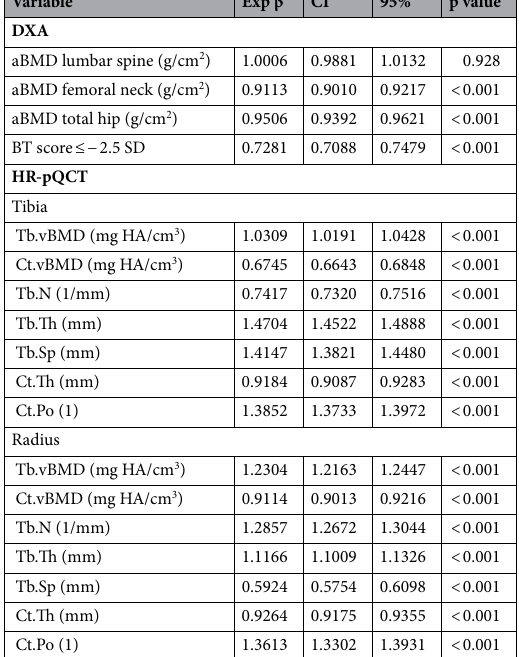
Table 5. Bone mineral density (DXA) and bone microarchitecture (HR-pQCT) for CAC status ( z score) in men. Exp β equation coefficient, aBMD areal bone mineral density, BT score bone T -score, SD standard deviation, Tb.vBMD trabecular volumetric density, Ct.vBMD cortical volumetric density, Tb.N average number of trabeculae, 1 mm, Tb.Th trabecular thickness, Tb.Sp separation between trabeculae, Ct.Th cortical thickness, CT.Po cortical porosity, CI confidence interval.